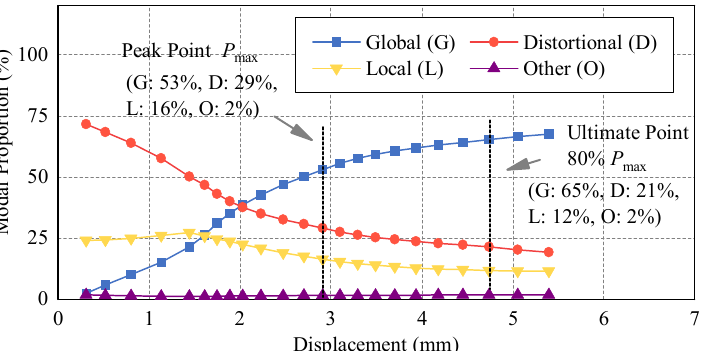
Figure 7. Full range modal participation of member FE simulation (member cross-section parameter is No.1, 2 mm thick, 600 mm long).